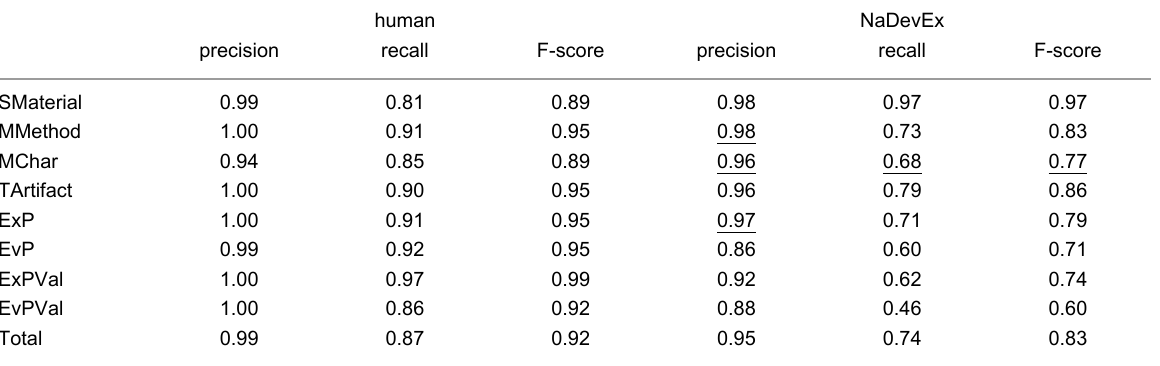
Table 3: Average performance of NaDevEx and the human annotation results for loose agreement compared with the annotation of the domain expert. human NaDevEx precision recall